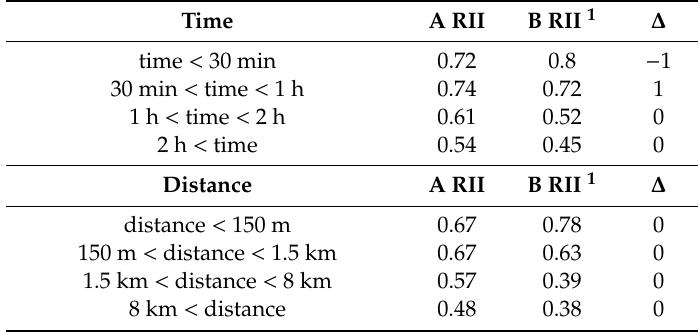
Table 4. Ideal time and distance for performing safety operation